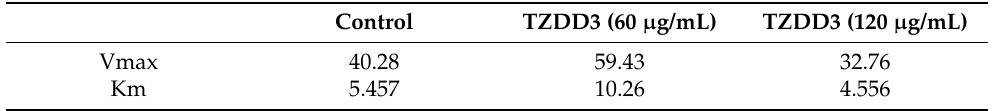
Figure 4. Lineweaver-burk plot of kinetic analysis of α -glucosidase inhibition by TZDD3 at 60 µg/mL. Table 2. Michaelis-Menten results, control is the substrate only, and TZDD3 is added with substrate to determine the effect on α -glucosidase inhibitory activity.